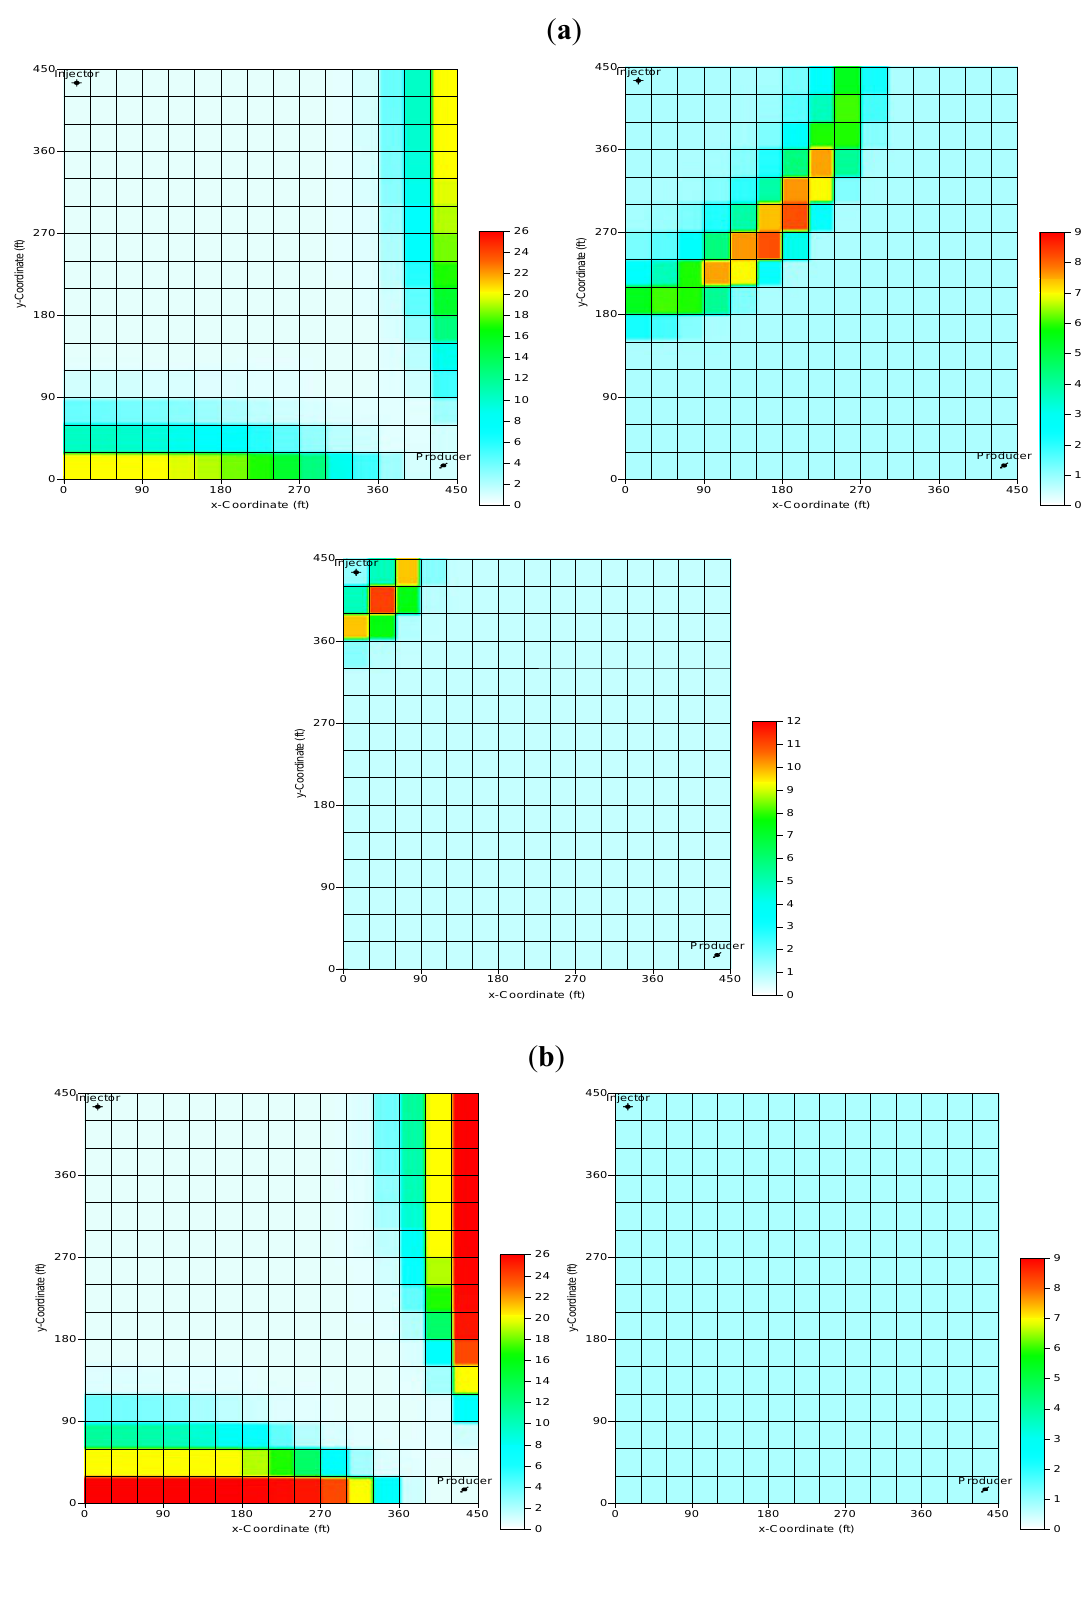
Figure 3. Water phase viscosity of layers 1, 3, and 5 at 1,283 days for 0/ = ( ) 5697.1ln = k σ with different